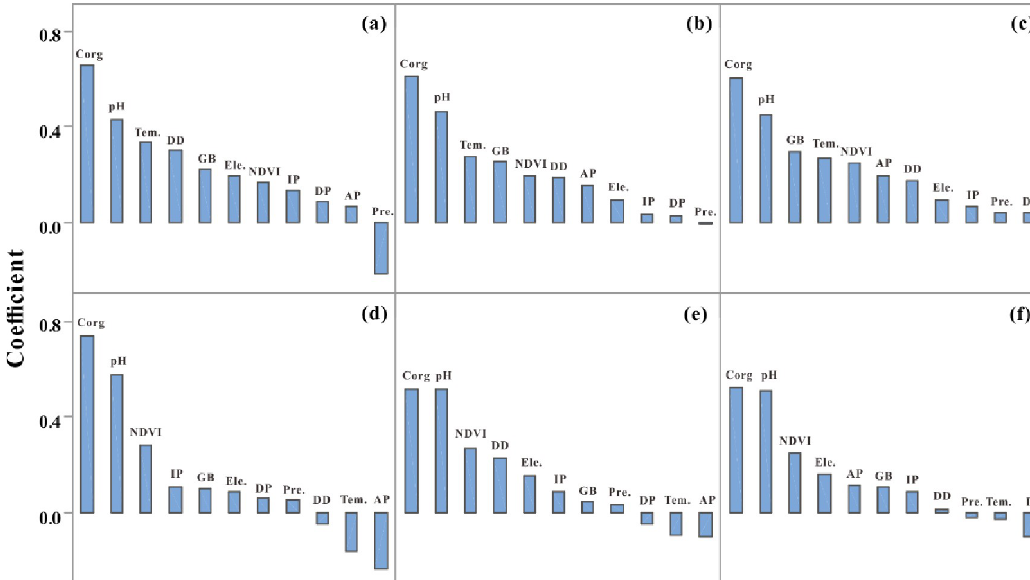
Fig 3. Coefficients of driving factors (Tem.: Temperature; Ele.: Elevation; GB: Geological background; DD: Deposit density; IP: Industrial pollutants; DP: Domestic pollutants; AP: Agricultural pollutants; (a) Strongly Cd-enriched area for CGB I; (b) Moderately Cd-enriched area for CGB I; (c) Cd background area for CGB I; (d) Strongly Cd-enriched area for CGB II; (e) Moderately Cd-enriched area for CGB II; (f) Cd background area for CGB II).